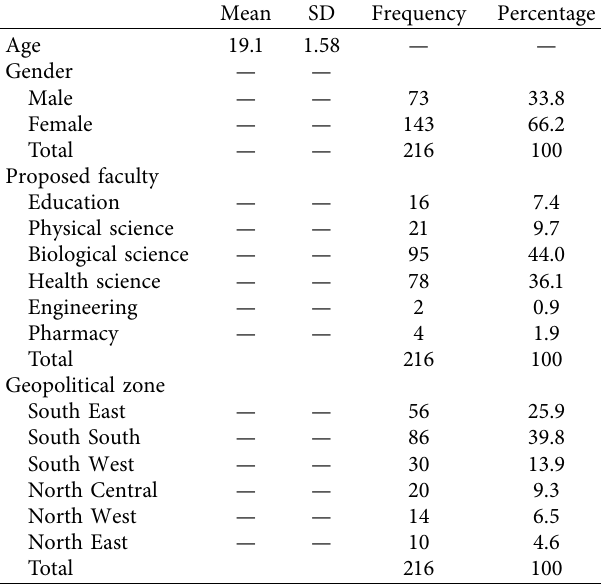
Table 2: Validity and reliability of the constructs. Table 1: Descriptive statistics of the participants’ demographic